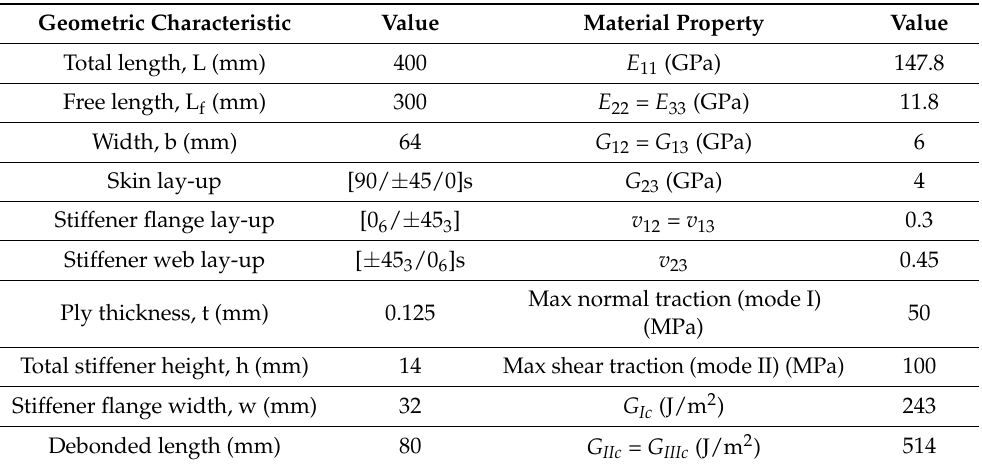
Table 1. Geometric characteristic and material properties of the SSCS